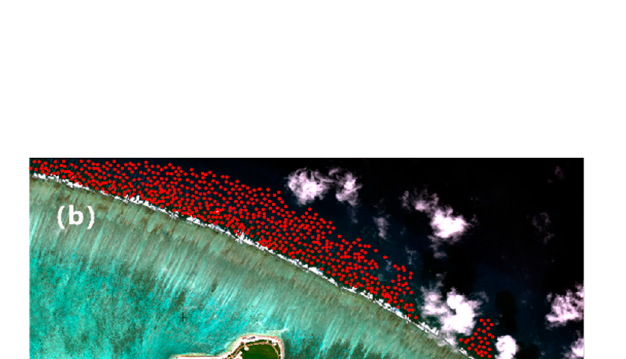
10 of 22 Table 1. Parameter information of WorldView-2 images in two regions. Research Regions